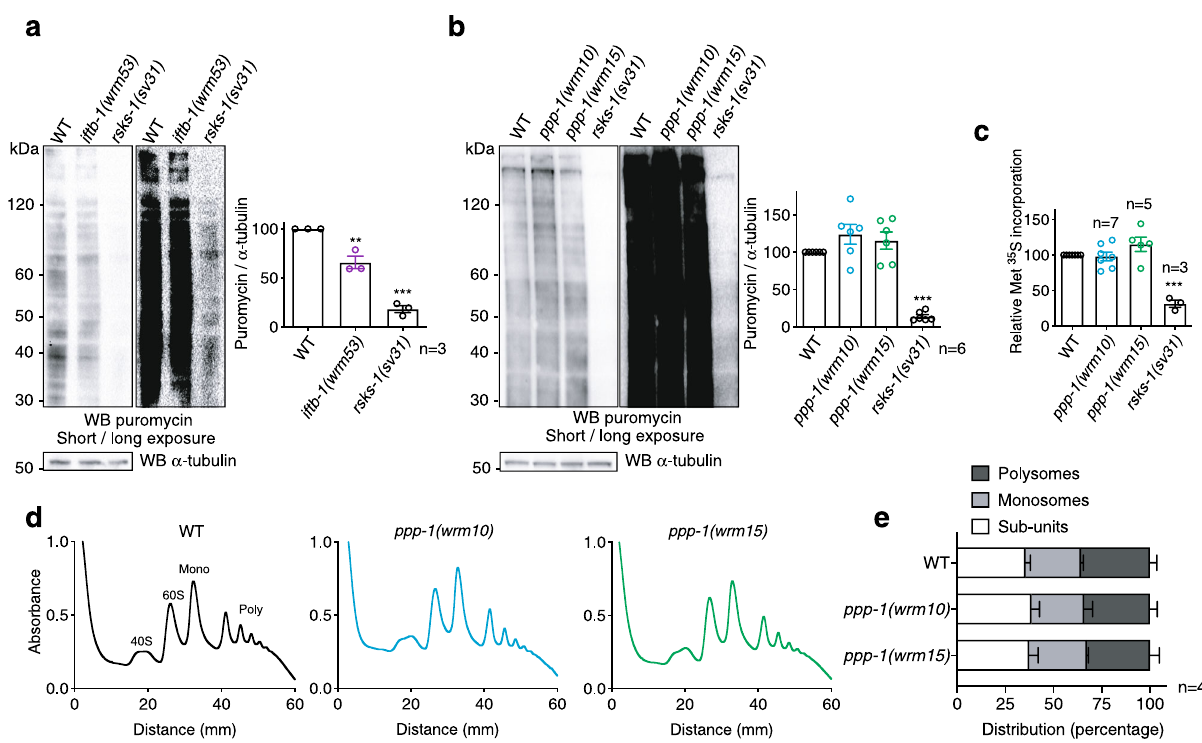
Fig. 2 Mutations in ppp-1 do not attenuate mRNA translation. a Puromycin incorporation followed by Western blot analysis using antibodies detecting puromycin and α -tubulin in day 1 WT animals, iftb-1(wrm53) mutants, and control rsks-1(sv31) mutants. Images of the same membrane are shown with short and long exposures (error bars represent means + SEM, one-way ANOVA Dunnett ’ s post hoc test with ** p = 0.0023 iftb-1(wrm53) vs. WT and *** p < 0.001 rsks-1(sv31) vs. WT; n = 3 independent experiments). b Puromycin incorporation assay in day 1 WT animals, ppp-1 mutants, and rsks-1(sv31) controls as described in ( a ). Images of the same membrane are shown with short and long exposures (error bars represent means + SEM, one-way ANOVA Dunnett ’ s post hoc test with *** p < 0.001 vs. WT; n = 6 independent experiments). c Quanti fi cation of methionine 35 S labeling of day 1 WT worms, ppp-1 mutants, and control rsks-1(sv31) mutants (error bars represent means + SEM, one-way ANOVA Dunnett ’ s post hoc test with *** p < 0.001 vs. WT; the number of independent experiments ( n ) indicated in the fi gure). d , e Polysome pro fi ling, and quanti fi cation of day 1 WT and ppp-1 animals. Quanti fi cation represents the relative abundance of ribosomal subunits (40S, 60S), monosomes (mono), and polysomes (poly; error bars represent means + SD, two-way ANOVA Dunnett ’ s post hoc test; n = 4 independent experiments). Source data are provided as a Source Data fi